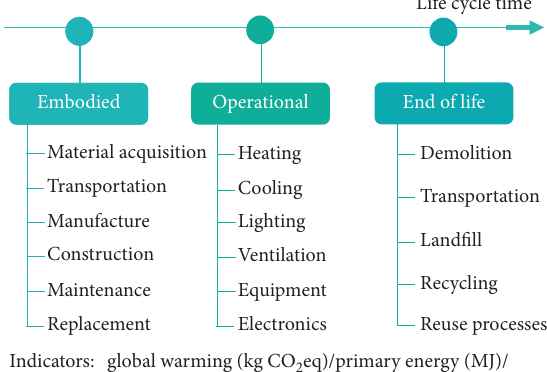
Figure 3: Life cycles and indictors of sustainable